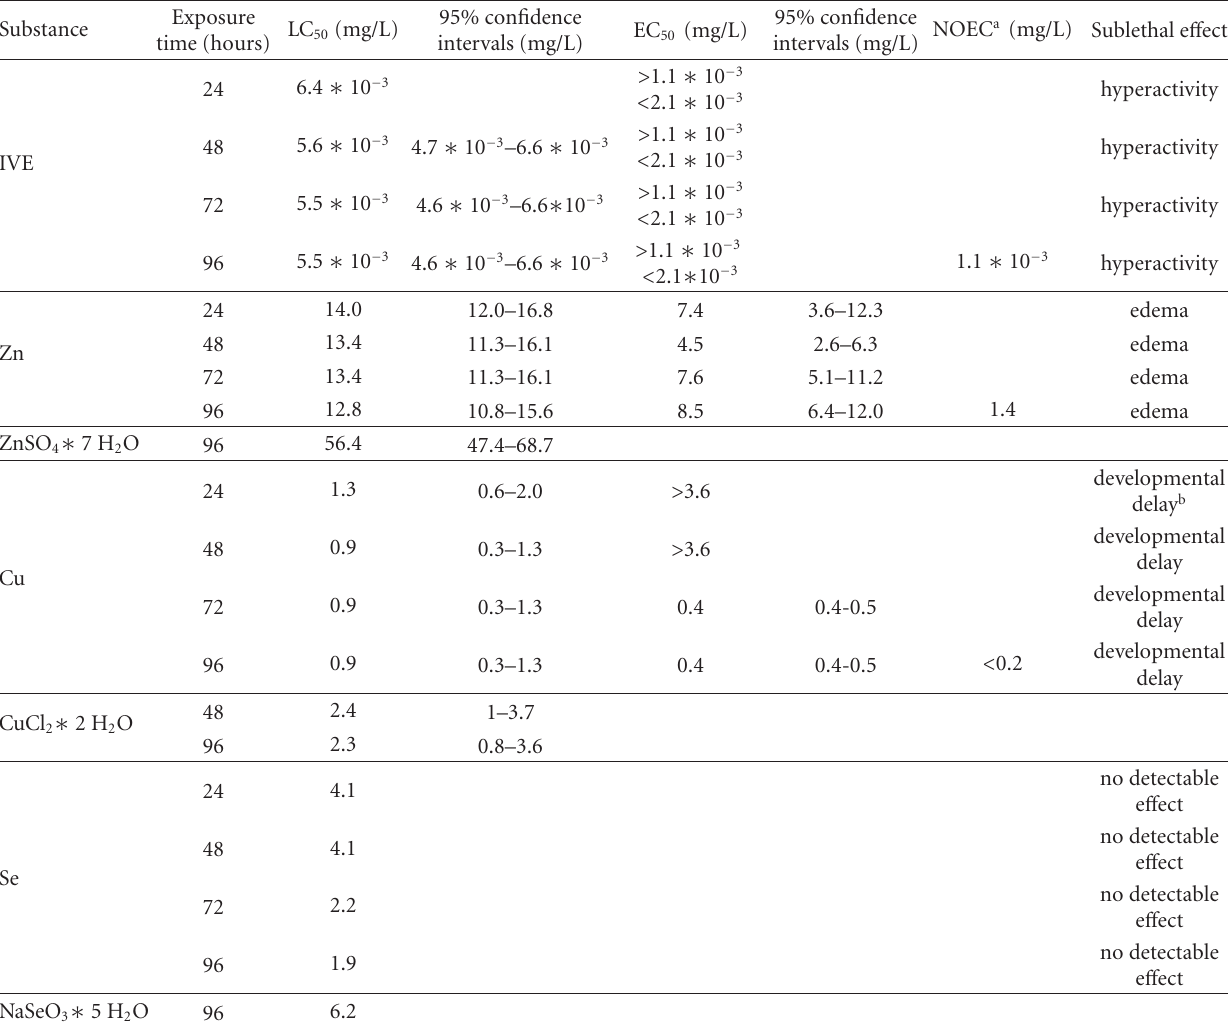
Table 2: Endpoints studied at each exposure time for ivermectin (IVE), zinc (Zn), copper (Cu), selenium (Se). Lethal and e ff ect concentra- tions in the 50% of the cases (EC 50 and LC 50 ) were shown at 24, 48, 72 and 96 hours. At each exposure time, the EC 50 values were related to the corresponding sublethal e ff ect. For the water-soluble forms of the metals: zinc sulphate (ZnSO 4 ∗ 7 H 2 O) and sodium selenite (NaSeO 3 ∗ 5 H 2 O) the 96h LC 50 were reported, and for copper chloride (CuCl 2 ∗ 2 H 2 O) both 48h and 96h LC 50 s were showed.